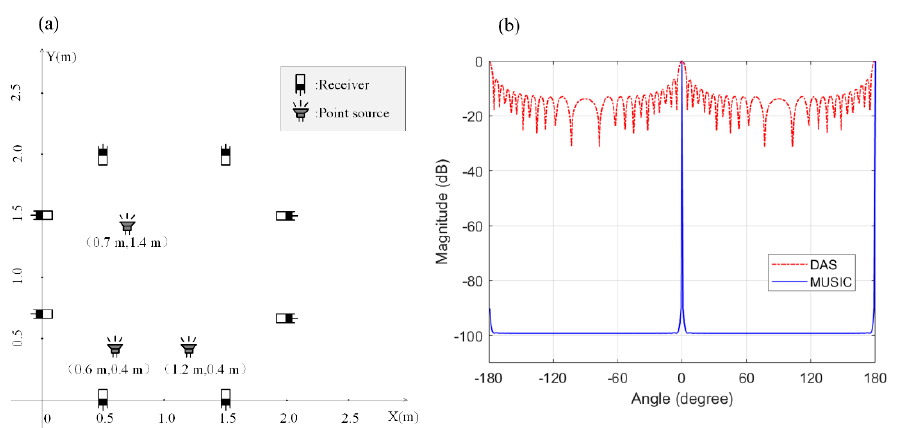
Figure 4. Geometry of the simulation performed in MATLAB ( a ) and the directivity pattern of microphone array ( b ).